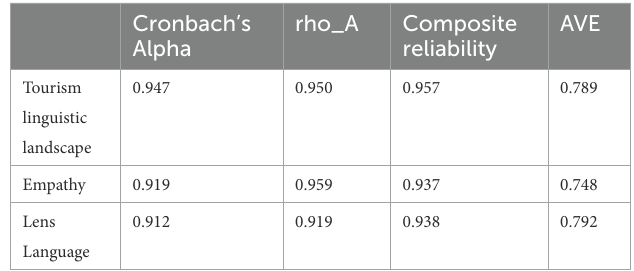
TABLE 2 Reliability tests of latent